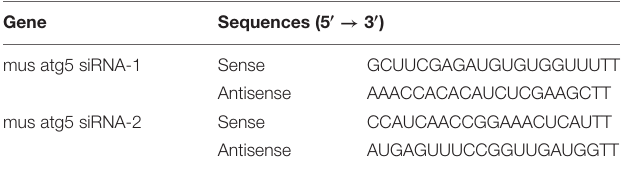
TABLE 1 | The Atg5 siRNA sequences for mouse.